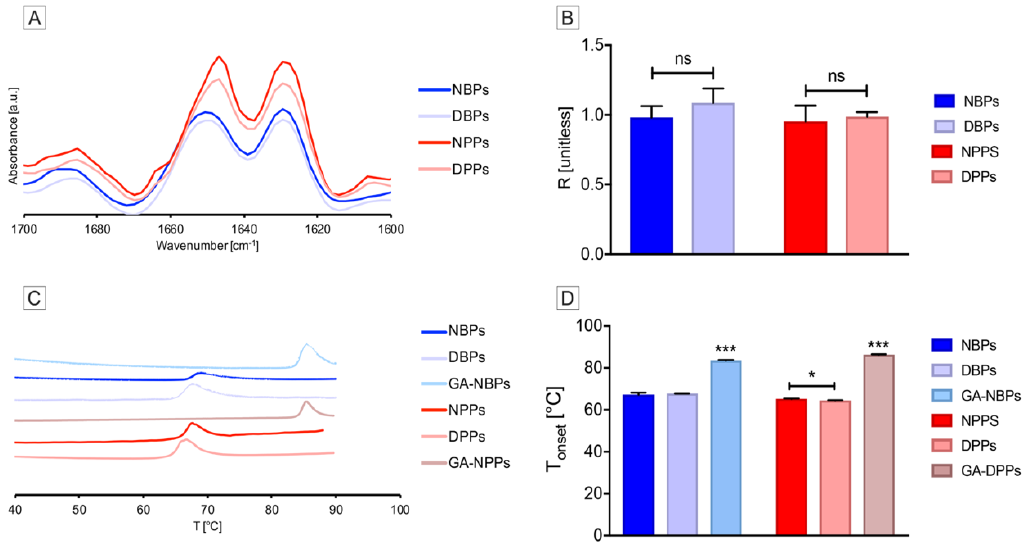
Figure 6. Denaturation profiles of bovine and porcine pericardia before and after TRICOL decellularization. ( A ) Second derivatives of the recorded spectra between 1600 and 1700 cm − 1 . No modifications were induced by TRICOL decellularization on the secondary structure, i.e., α -helical structures (1650 cm − 1 ) and ß-sheets (1630 cm − 1 ). ( B ) R ratio. R was not significantly modified by TRICOL decellularization in both species’ tissues. ( C ) Di ff erential scanning calorimetry (DSC) thermograms. Similar profiles were observed when decellularized and native pericardia of both species were compared. Glutaraldehyde treatment sensibly modified tissue thermograms. ( D ) The onset temperature (T onset ) of protein denaturation. Denaturation occurred at decreased temperature with respect to native tissues only for porcine pericardium. Glutaraldehyde treatment caused a significant increase of the denaturation temperature for both species with respect to all other groups considered. Data are presented as mean ± standard deviation (SD). * p < 0.05, *** p < 0.001. NBP = Native Bovine Pericardium, DBP = Decellularized Bovine Pericardium, NPP = Native Porcine Pericardium, DPP = Decellularized Porcine Pericardium, and GA = Glutaraldehyde.